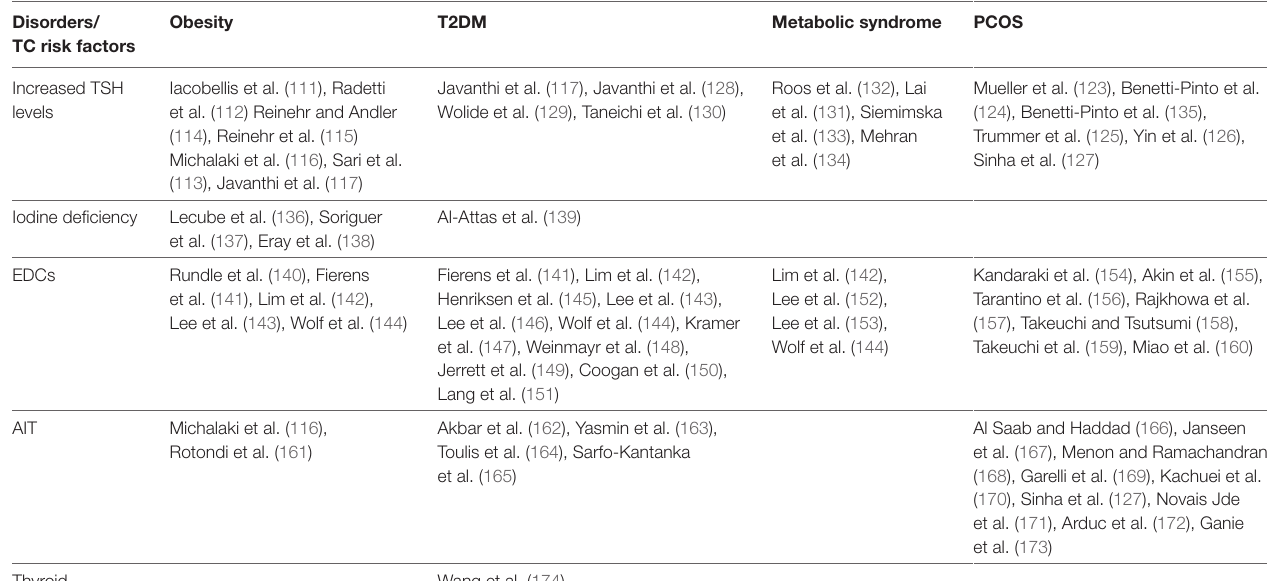
TAble 2 | Studies showing a possible interplay between insulin resistance related disorders and some TC risk